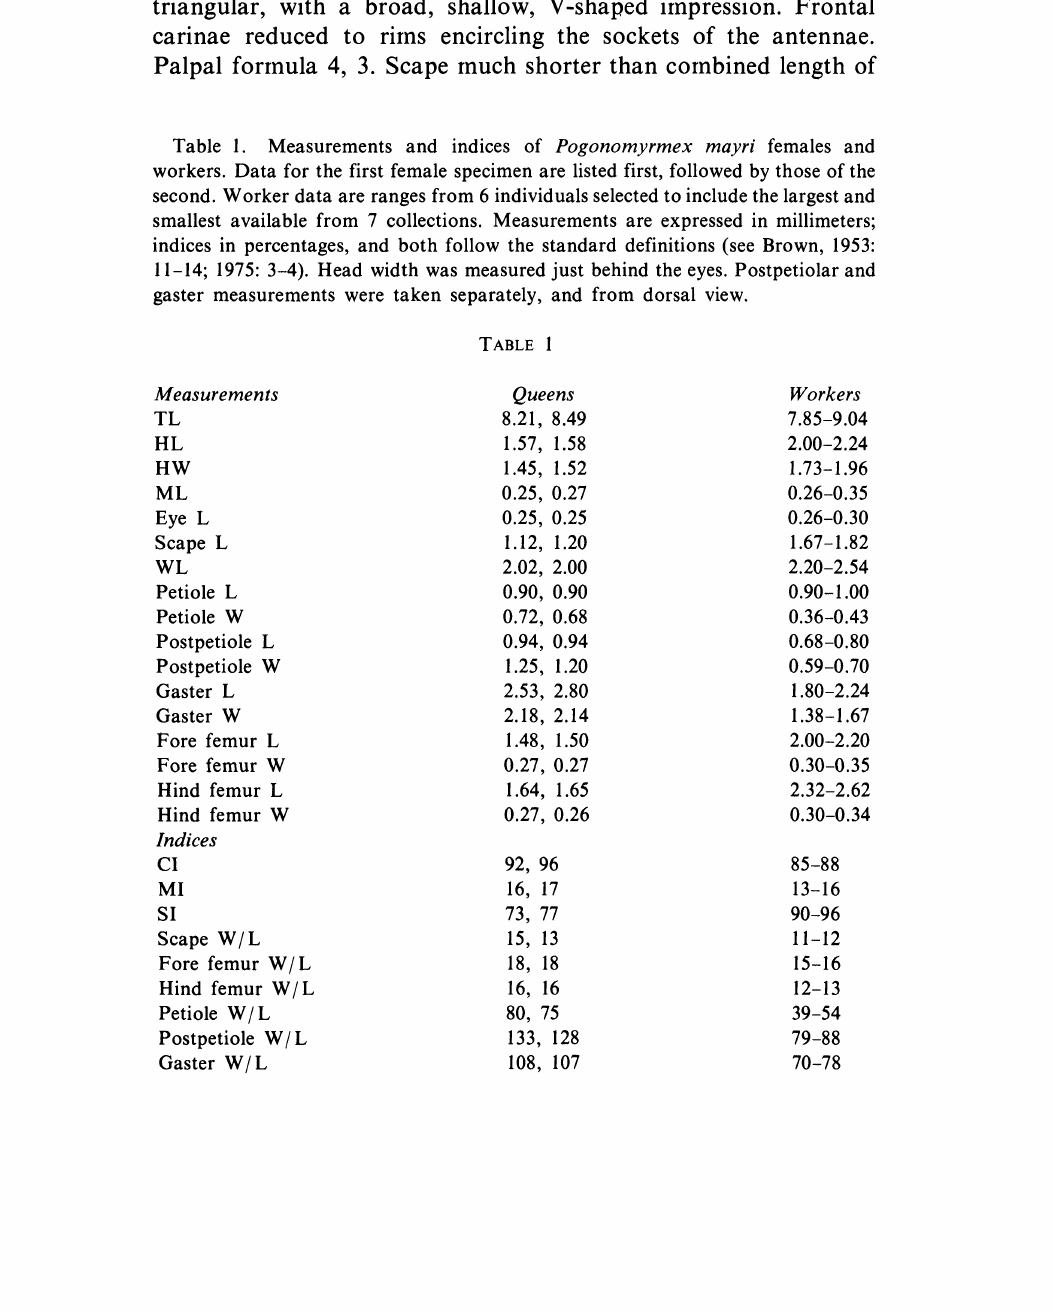
Table 1. Measurements and indices of Pogonomyrmex mayri females and workers. Data for the first female specimen are listed first, followed by those of the second. Worker data are ranges from 6 individuals selected to include the largest and smallest available from 7 collections. Measurements are expressed in millimeters; indices in percentages, and both follow the standard definitions (see Brown, 1953: 11-14; 1975: 3-4). Head width was measured just behind the eyes. Postpetiolar and gaster measurements were taken separately, and from dorsal